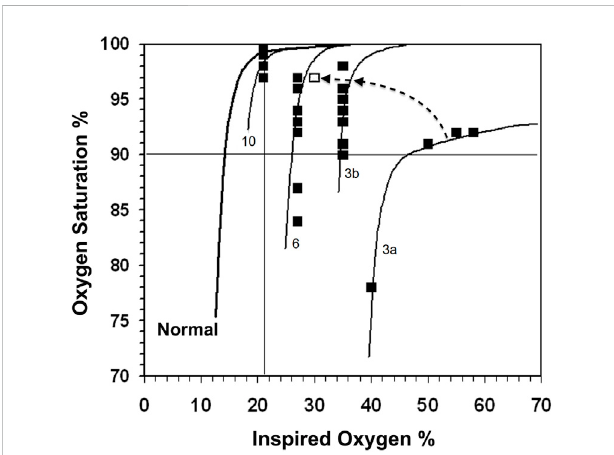
FIGURE 3 The normal P I O 2 vs. SpO 2 curveis shown on the left. SpO 2 readings (closed boxes) with the calculated gas exchange model curves for infants 3, 6 and 10. Infant 3 had 27% shunt and V A /Q of 0.24 (3a), which resolvedduringthedaytoasingleV A /Qcompartmentof0.22anda SpO 2 range of 8% (3b) and subsequently into a fi nal point (open box) at the end of the day to almost overlying the V A /Q 0.31 line of infant 6 (the changes are indicated by the dashed arrow). Infant 6 initially had a 21% shuntandV A /Qof0.43(notshowninFigure),whichresolvedintoaV A /Q of 0.31 in the 9 – 24 h study period. Infant 10 had a V A /Q of 0.56 and a SpO 2 range of 3% from 24 SpO 2 values.